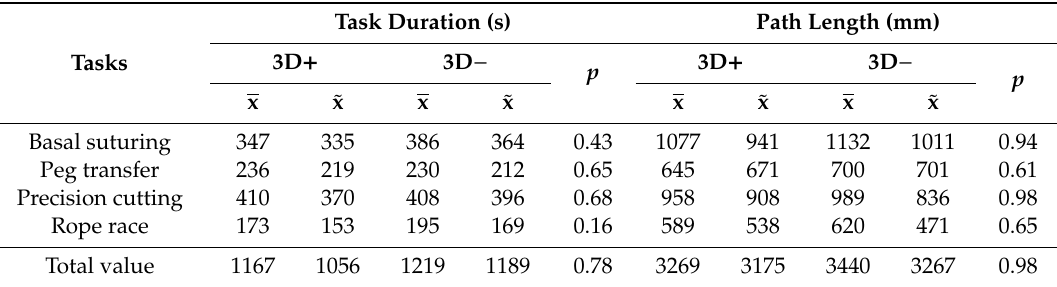
Table 1. Task duration and path length of participants using the two systems, 3D + with glasses and 3D − without glasses, for each